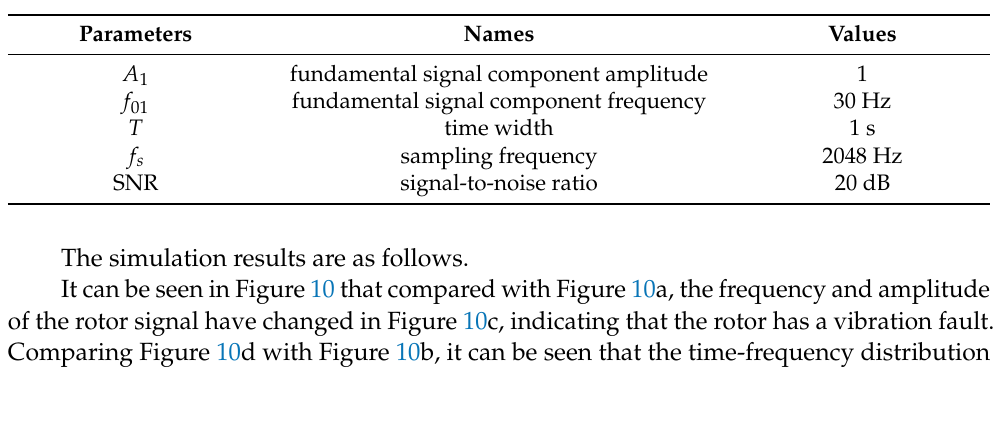
Table 7. Parameters of the rotor bearing wear vibration fault signal.